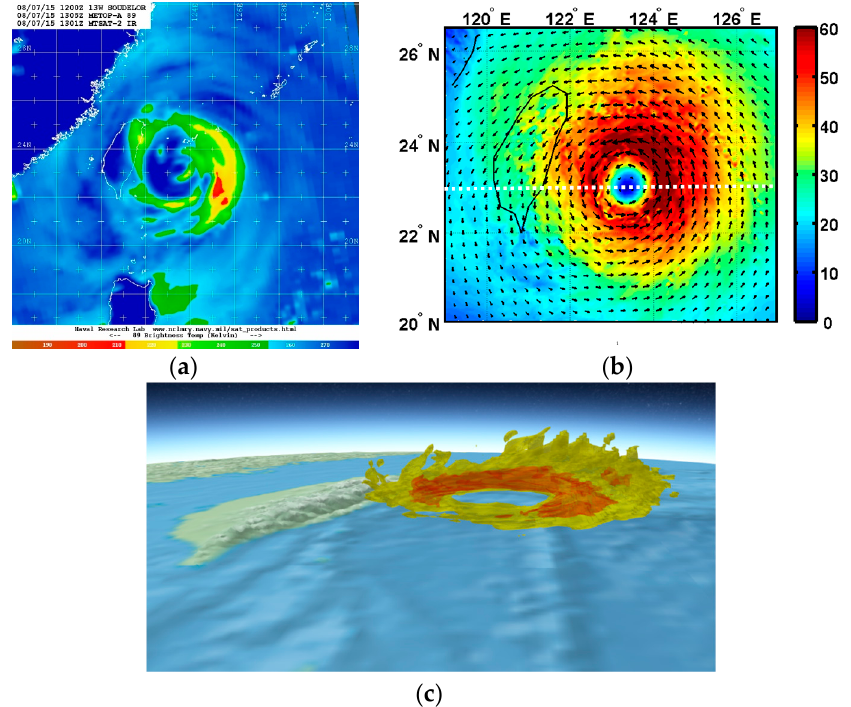
Figure 4. ( a ) Brightness temperature on 7 August 13:00 UTC (from the U.S. Naval Research Laboratory database). ( b ) WRF simulated wind speed (m/s) at height of 4 km with horizontal wind vectors (black) on 7 August 12:00 UTC. The white dotted line crosses the TC center at latitude of 23° N. ( c ) Isosurfaces of wind speed of 60 m/s (yellow) and 75 m/s (red) on 7 August 12:00 UTC using Weather 3D software.